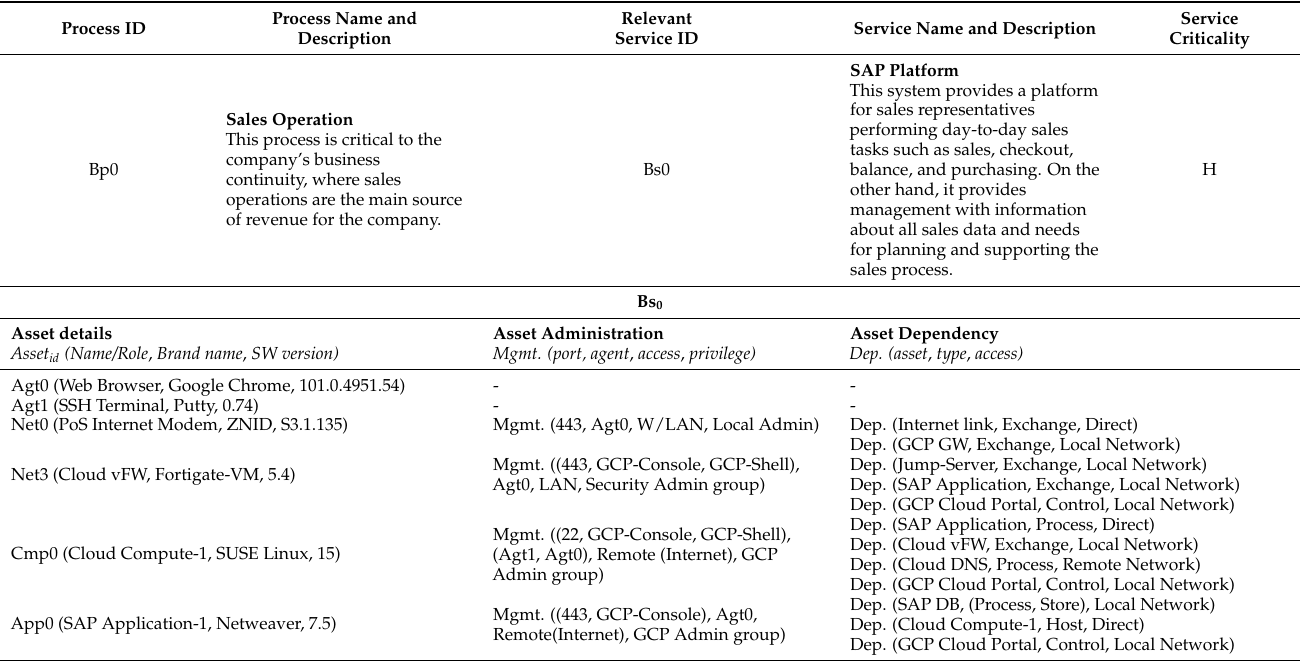
Table 5. Table of critical business processes, services and